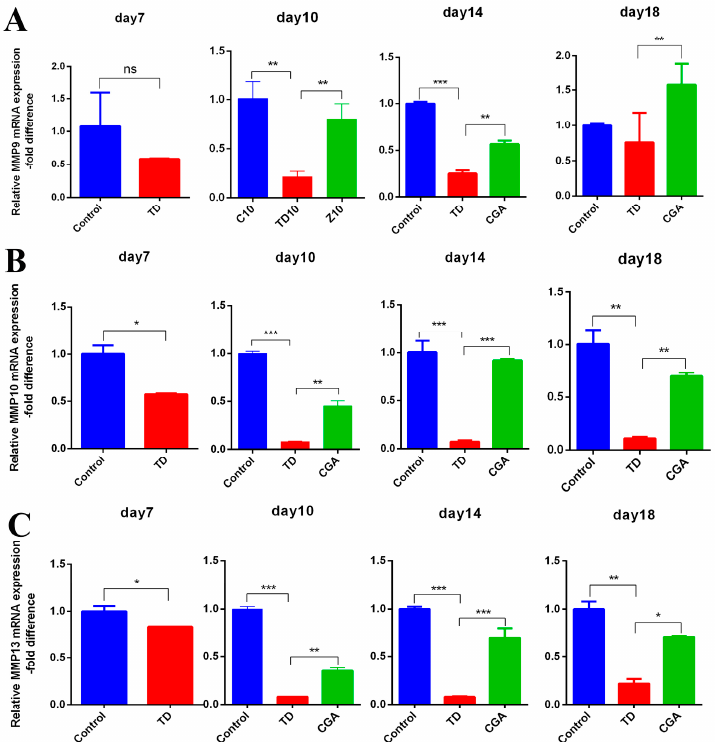
Figure 7. CGA regulates expression of ECM catabolic genes in growth plate. ( A – C ) The relative mRNA expression of MMP 9, MMP 10, MMP 13 in tibial growth plate were measured by RT-qPCR at days 7, 10, 14 and 18. GAPDH was used as an internal control. All of the data represent means ± SD of three independent experiments. * p < 0.05, ** p < 0.01, *** p < 0.001.